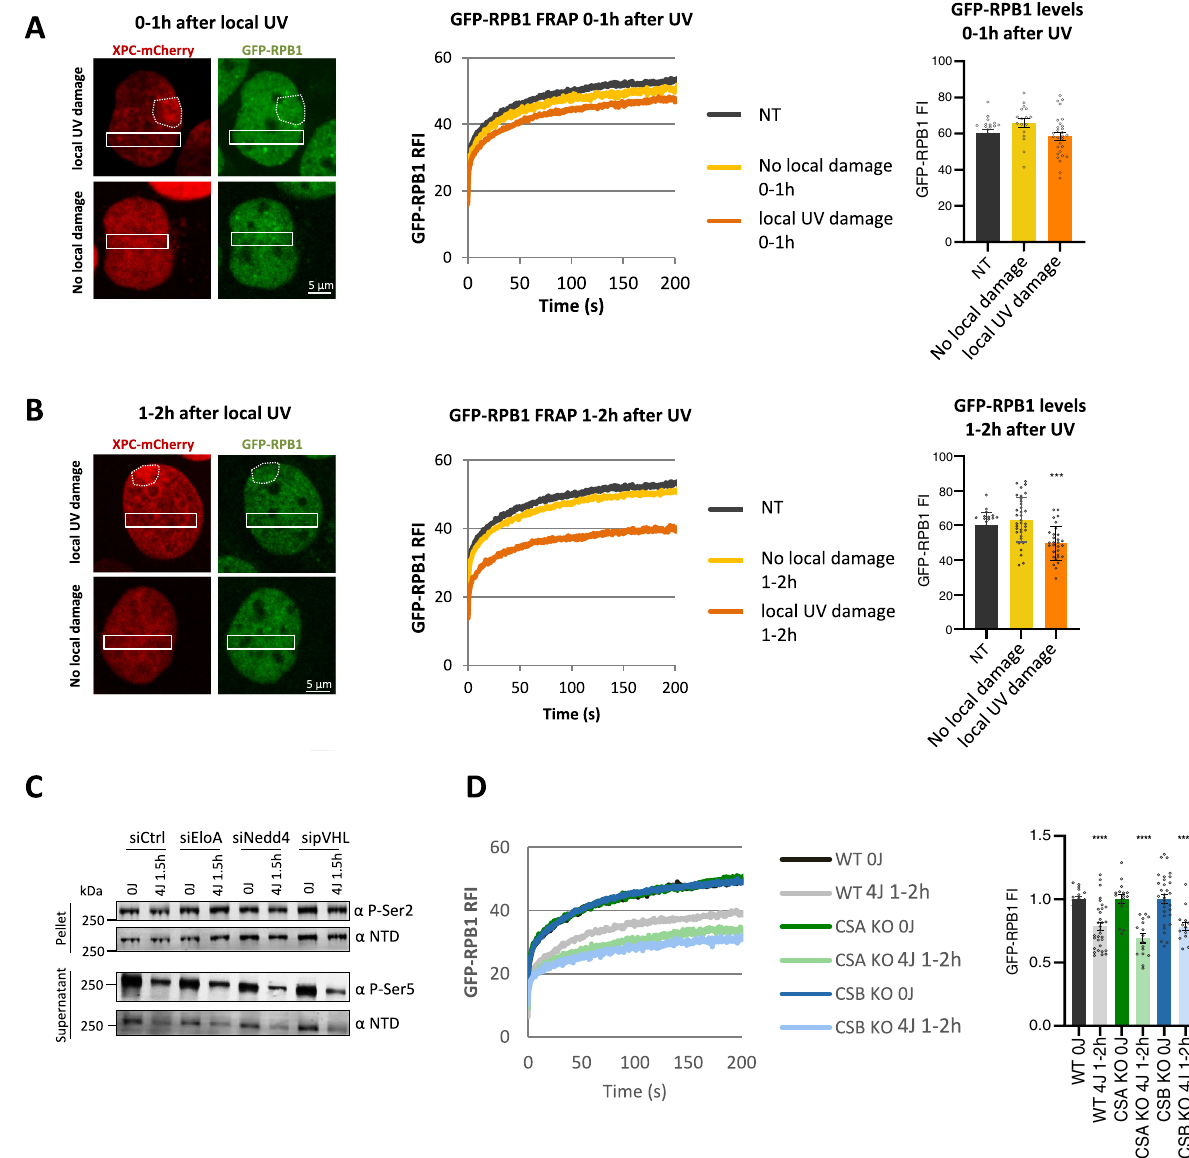
Fig. 4 The UV-induced degradation of promoter-bound Pol II is regulated in trans. a , b Left panels: Representative image of a GFP-RPB1 KI cell expressing XPC-mCherry as a live-cell damage marker within 1 h ( a ) or 1 to 2 h ( b ) after UV irradiation through a porous fi lter to induce local DNA damage. Cells containing local UV-damage (top images) are marked by local accumulation of XPC-mCherry (outlined with dotted circle) or without local damage (bottom images), or non-treated cells (NT) were used for FRAP analysis. GFP-RPB1 FRAP was analyzed outside the local UV damaged, indicated by box. Middle panels: FRAP analysis of GFP-RPB1 cells that were non-treated (NT) or 0 – 1 h ( a ) or 1 – 2 h ( b ) after local UV irradiation through a porous fi lter. Right panels: GFP-RPB1 pre-bleach fl uorescence intensity (FI) ± SD of cells analysed by FRAP as a measure for Pol II protein levels. N = 23 cells for ‘ NT ’ , n = 10 cells for ‘ no local damage 0 – 1 h ’ , n = 29 cells for ‘ local UV damage 0 – 1 h ’ , n = 35 cells for ‘ no local damage 1 – 2 h ’ , n = 30 cells for ‘ local UV damage 1 – 2 h ’ . Cells were measured in 3 independent experiments. c Western blots after cellular fractionation of GFP-RPB1 knock in (KI) cells after control siRNA transfection (siCTRL), or siRNA-mediated gene knockdown of the indicated E3 ubiquitin ligases in non-perturbed conditions (0 J) or 1 h after irradiation with 4 J/m 2 (4 J). NTD = RPB1 N-terminal domain, P-Ser = phospho-serine. Experiment has been performed two times with similar results. d Fluorescence recovery after photo-bleaching (FRAP) of GFP-RPB1 in wild type (WT) or in NER knock out (KO) MRC5 cells without UV irradiation (0 J) or 1 h after irradiation with 4 J/m 2 (4 J 1 h). GFP-RPB1 was bleached and fl uorescence intensity was measured every 0.4 sec, background-corrected and normalized to pre-bleach fl uorescence intensity (FI), which was set to 100. RFI = relative FI. Right panel: Mean ±SD of pre-bleach GFP-RPB1 FI as a measure for Pol II protein levels in nuclei analysed by FRAP. N = 32 cells for ‘ WT 4 J 1 – 2 h ’ and ‘ CSB KO 0 J 1 – 2 h ’ measured in 4 independent experiments, n = 16 cells for all other conditions measured in 2 independent experiments. ** *P ≤ 0.001, **** P ≤ 0.0001, analyzed by ordinary one-way ANOVA using Dunnett ’ s multiple comparisons test versus NT ( a , b ) or respective 0 J condition ( d